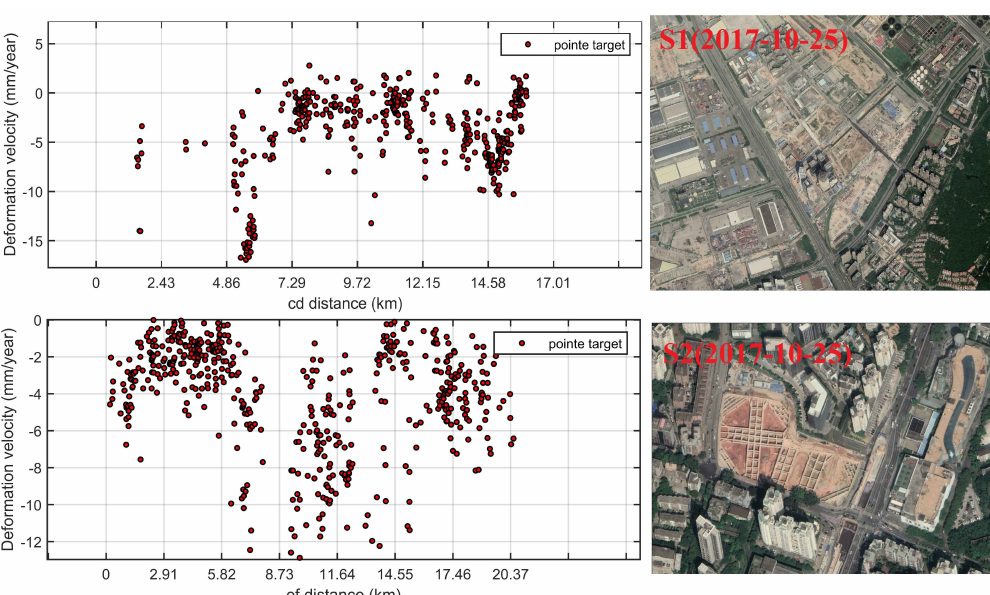
Figure 11. Cumulative deformation side view of cd and ef segments